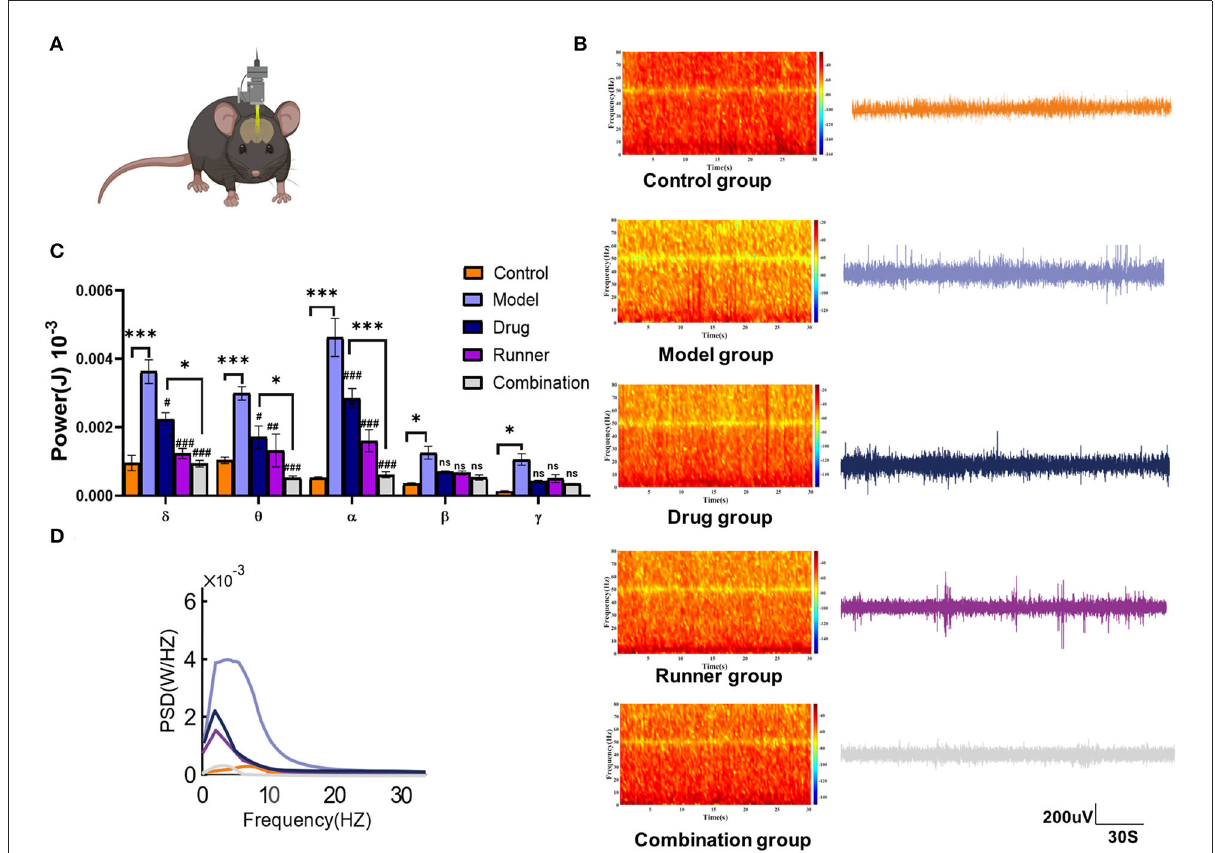
FIGURE5 LFP spectral characteristics and PSD in each group. (A) Diagram of local field potential recording in mice. (B) LFP signals and spectral heat maps from representative seizure mice treated with control (orange), model (lavender), drug (blue), runner (amaranth), and combination (gray) groups were displayed, respectively. (C) Spectral plots and cumulative distribution curves from model mice with no treatment, VPA, treadmill, and combination treatment were shown, respectively. (D) Spectral analysis on PSD values of δ , θ , α , β , and γ rhythm in each group. Data in (C) were shown as mean ± SEM. ns > 0.05, * P < 0.05, *** P < 0.001; # P < 0.05, ## P < 0.01, ### P < 0.001, compared with model group (two-way